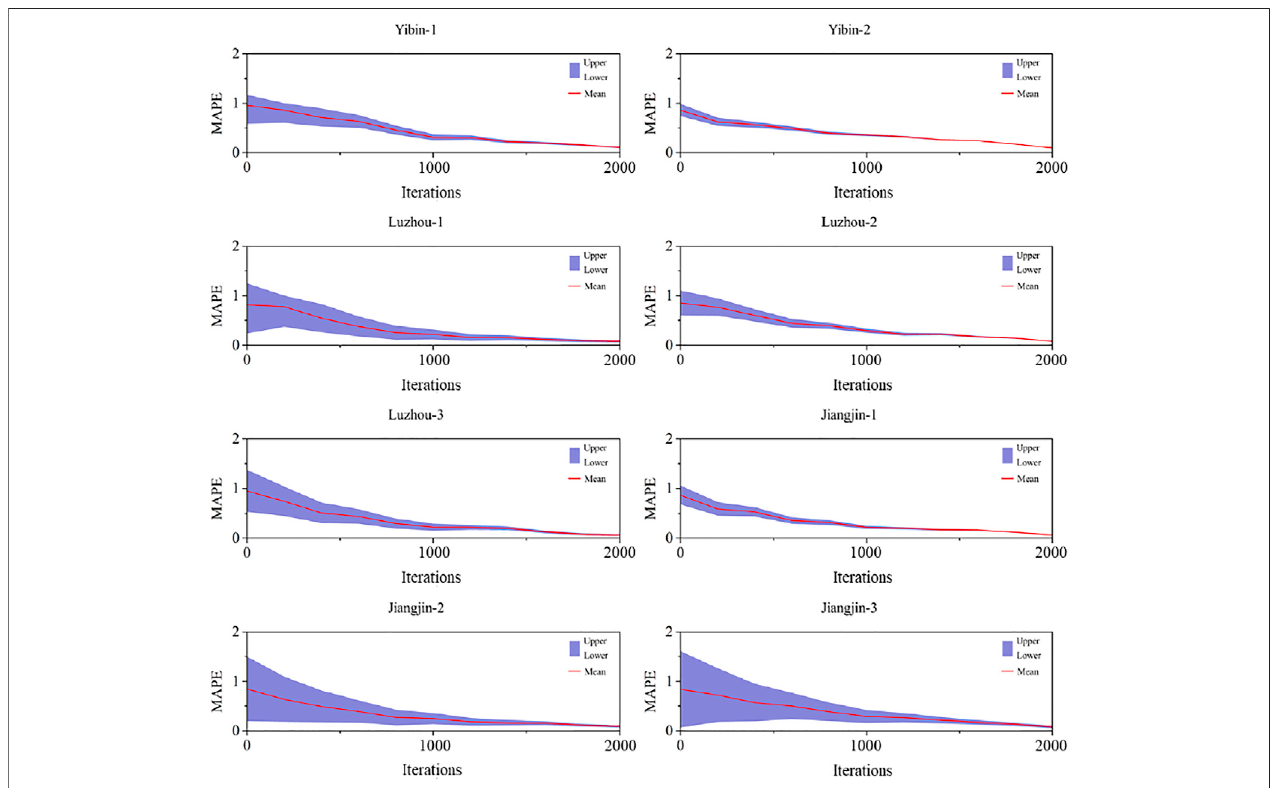
FIGURE 5 | Convergence of MAPE by iterations using IFPA algorithm.